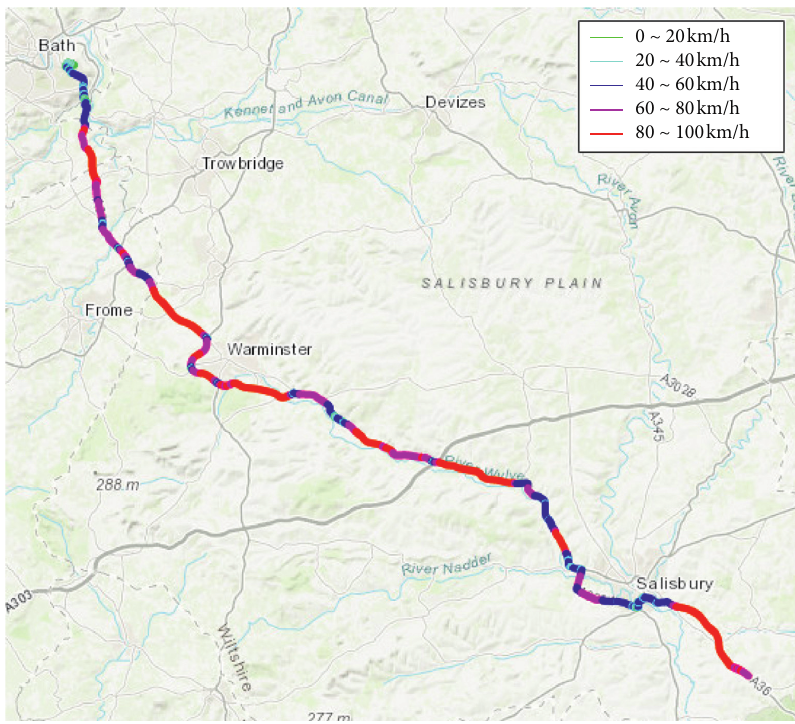
Figure 1: Route for driving data